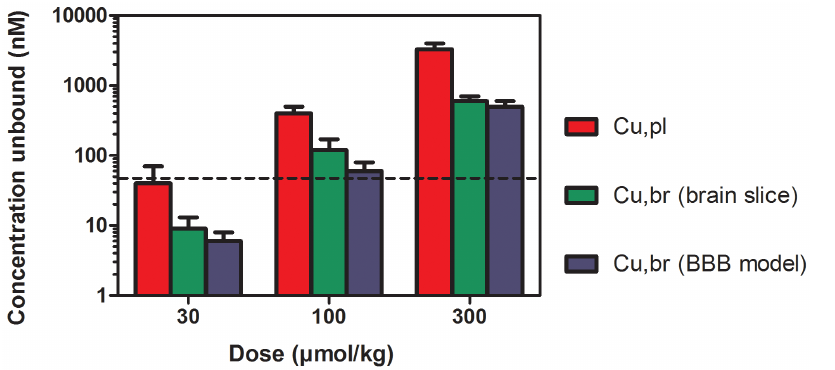
Figure 5. Comparisons between predicted free brain exposures (from Cu,br/Cu,pl invitro ) and invivo exposures in relation to estimated IC50 in brain for AZ13032000=55 nM based on invitro potency data.